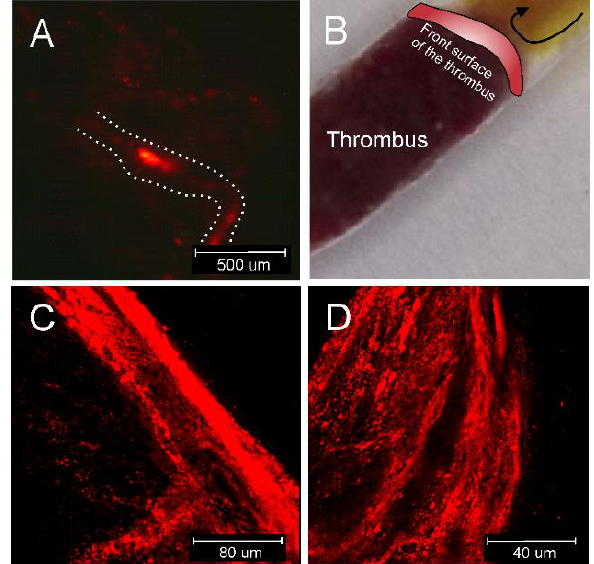
Figure 4. Targeting of fibrin filaments of the clot in the silicone MCA model under flow conditions visualized using fluorescent imaging. Fluorescent microscopic imaging of fluorescently-labelled liposomes (red) targeted to fibrin filaments of the clot in the MCA model. Focused plane of the front surface of thrombus is visualized inside MCA model ( A ). Schematic representation of the front area of the clot targeted by liposomes (red) under flow conditions ( B ). Confocal microscopy of the clot after extraction from the silicone model (cross-section). The front surface layer of the thrombus with highly targeted fibrin fibrils is clearly distinguishable from deeper layers with significantly lower number of liposomes using confocal microscopy. ( C ). Detail of cross-section ( D ).